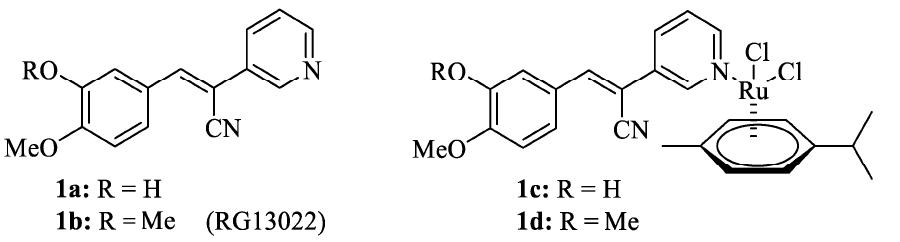
Figure 1. Structures of the anticancer active tyrphostins 1a – d .